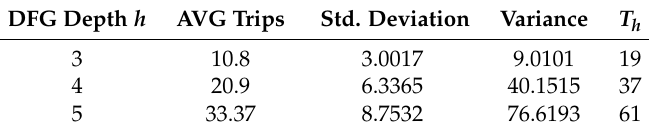
Table 6. Average trips per DFGs G 3 , G 4 , G 5 taken from a sample of 50 random